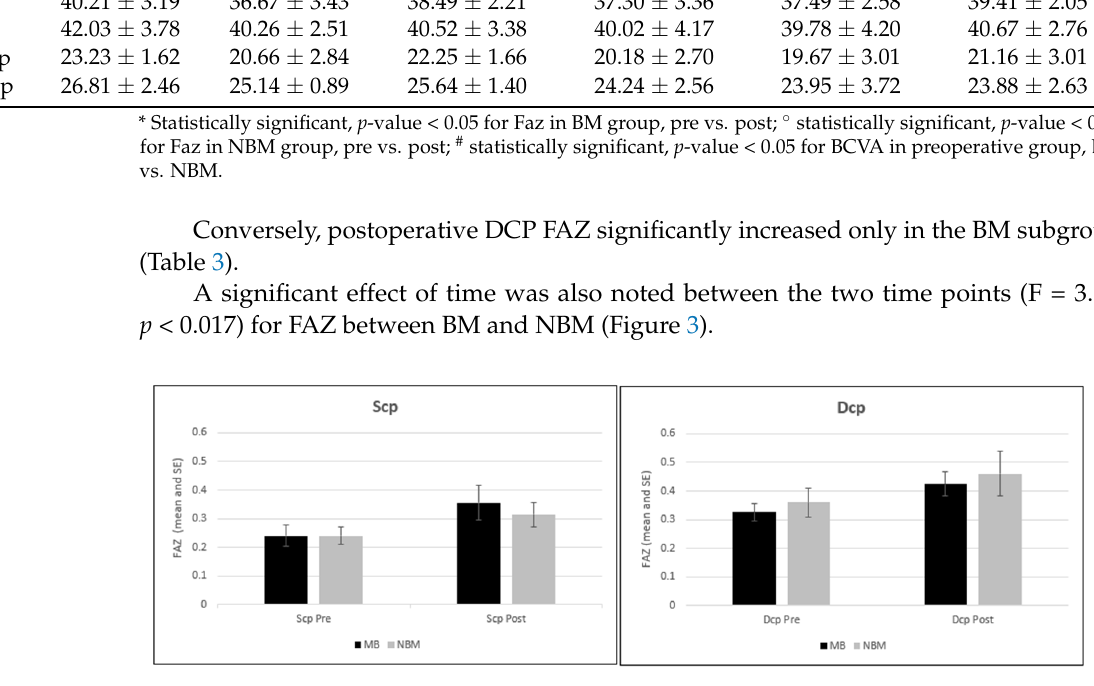
Figure 3. Estimated marginal means preoperative and postoperative described for each DCP and SCP plexuses for the BM and NBM groups.